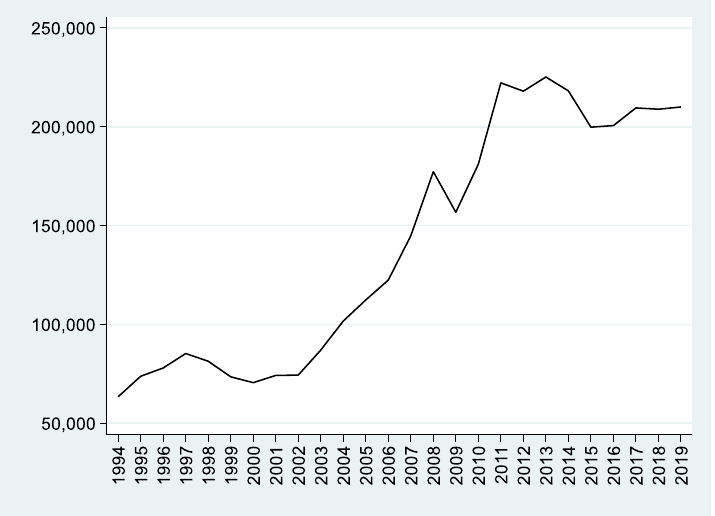
Figure 1. Evolution of agri-food exports from Latin America (billions of 2015 USD).